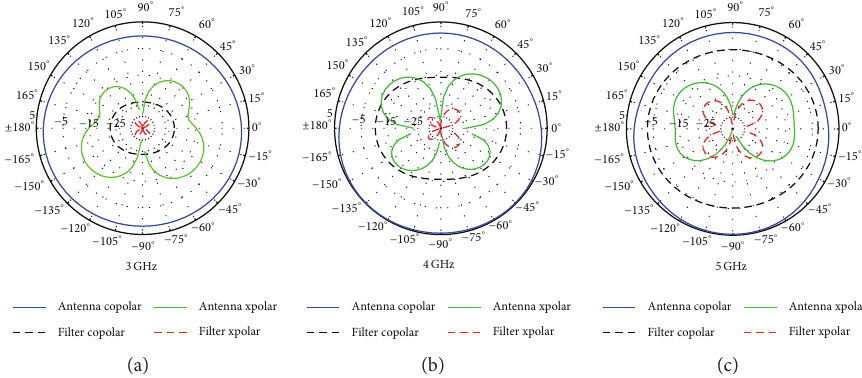
Figure 10: Simulated radiation pattern of the antenna and the filter in the H-plane (10dB/div).